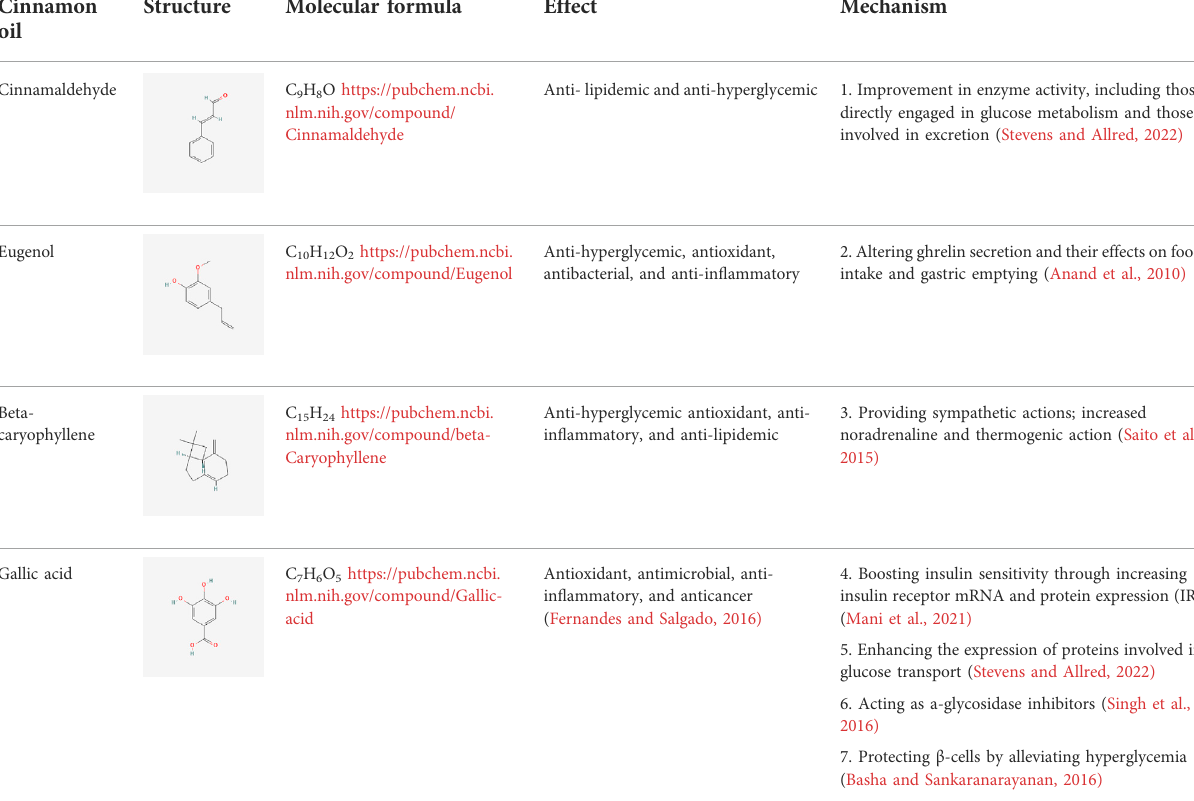
TABLE 4 Main components present in cinnamon and their mechanisms of action. Cinnamon